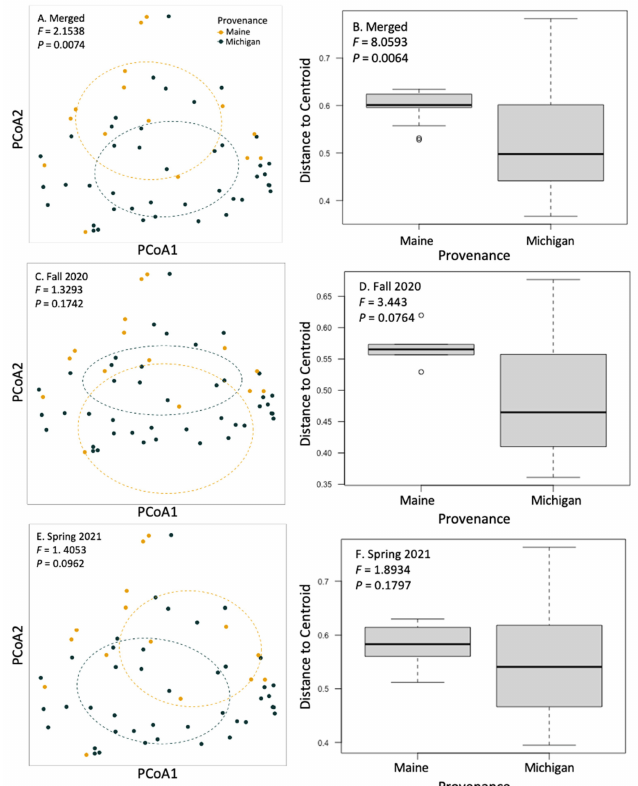
Figure 3. Principal coordinate analysis and beta dispersal of communities of fungi on the roots of sampled trees. We analyzed the effect of tree provenance on fungal community structuring and homogeneity of group dispersions. Fungal community composition did not respond to BLD symptomatology but did respond to tree provenance ( F = 2.1538; p = 0.0074) when fall 2020 and spring 2021 data were merged ( A , B ). When trees from each collection (fall 2020 and spring 2021) were analyzed alone, provenance differences trended towards significance, as indicated by PERMANOVA or PERMDISP ( C – F ).